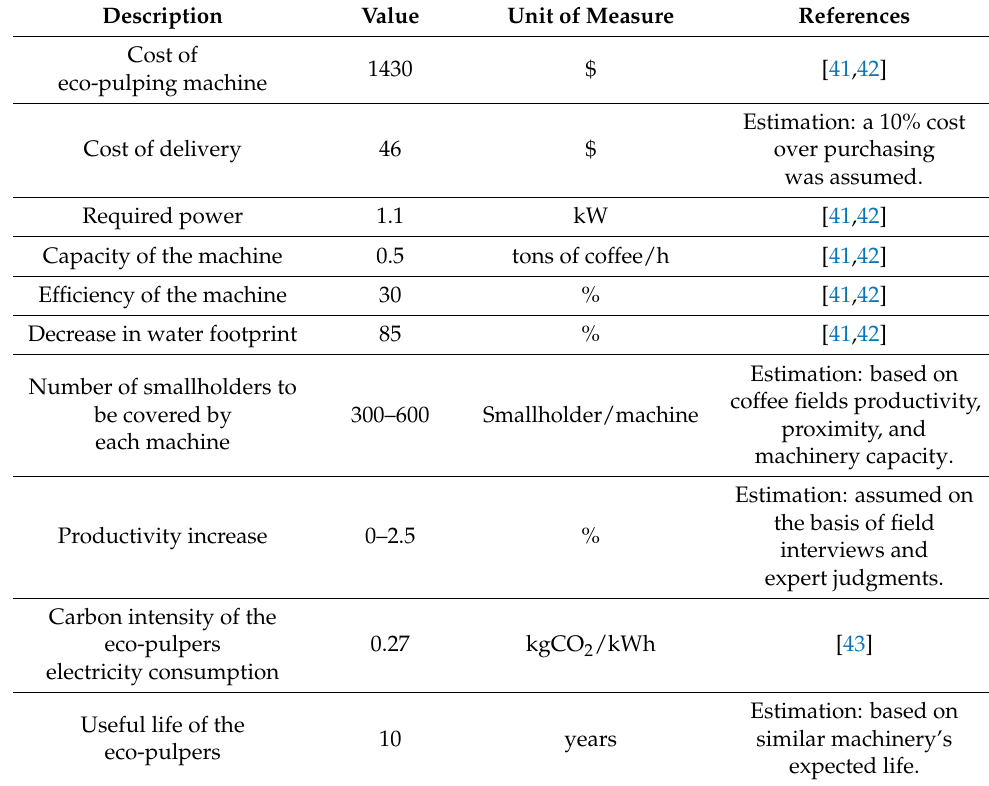
Table 2. Input parameters eco-pulpers intervention.